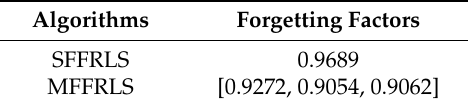
Table 3. Forgetting factors optimized by PSO.